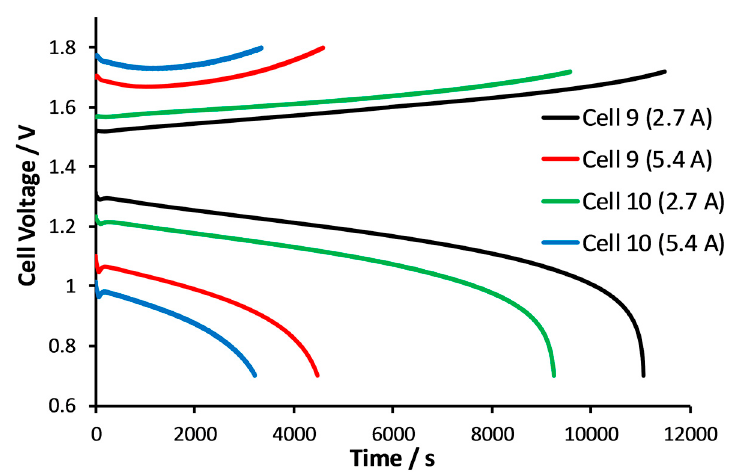
Figure 7. Charge-discharge curves obtained in a VRFB using Cells 9 and 10 at 90 and 174 mA cm − 2 (2.7 and 5.4 A), with a flow rate of 100 mL min − 1 .